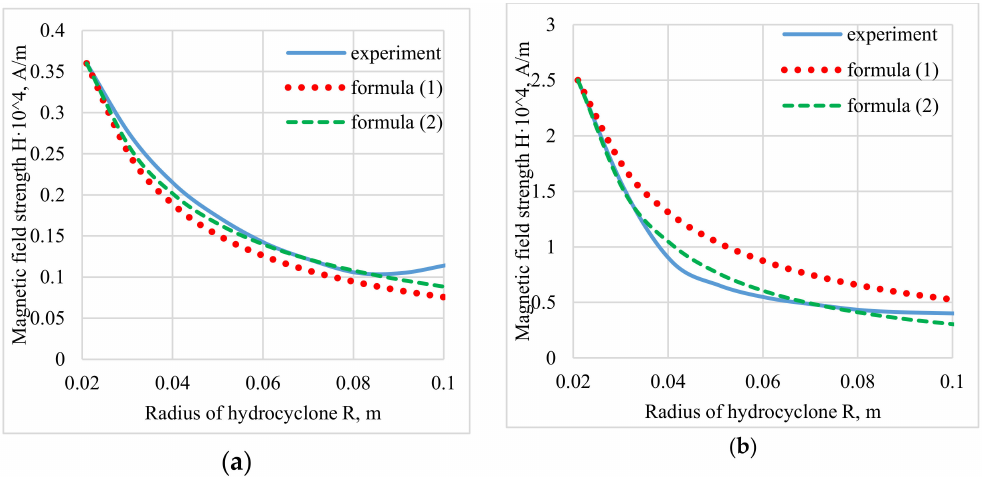
Figure 3. The change in magnetic field strength along the radius at various currents in the winding: ( a ) I = 1 A; ( b ) I = 8 A.